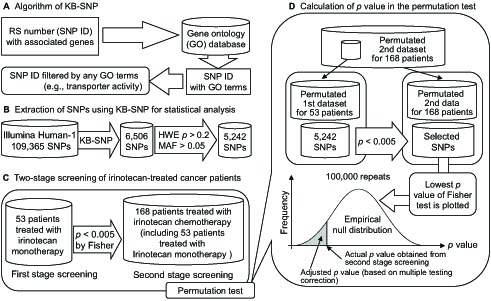
An outline of chemotherapeutic response analysis in irinotecan-treated cancer patients using a combined method consisting of a knowledge-based algorithm for identifying SNPs (KB-SNP), 2 stages of screening, and the permutation test.(A) The KB-SNP algorithm. (B) Extraction of SNPs using KB-SNP for statistical analysis. (C) Two-stage screening of irinotecan-treated cancer patients. (D) Calculation of the p value in the permutation test based on the 2 stages of screening. The second dataset (includes first dataset) was permutated. The permutated first dataset was extracted from the permutated second dataset. By using Fisher's exact test, SNPs with p<0.005 for the first dataset were selected from among 5,242 SNPs. Among the selected SNPs, those with the lowest p value in Fisher's exact test for the second dataset were selected. This procedure was repeated 100,000 times and empirical null distribution was constructed. Using the distribution, the actual p value obtained from the second stage of screening was converted to the adjusted p value (based on correction of multiple testing problems). At these screening steps, allele models were used for each SNP.